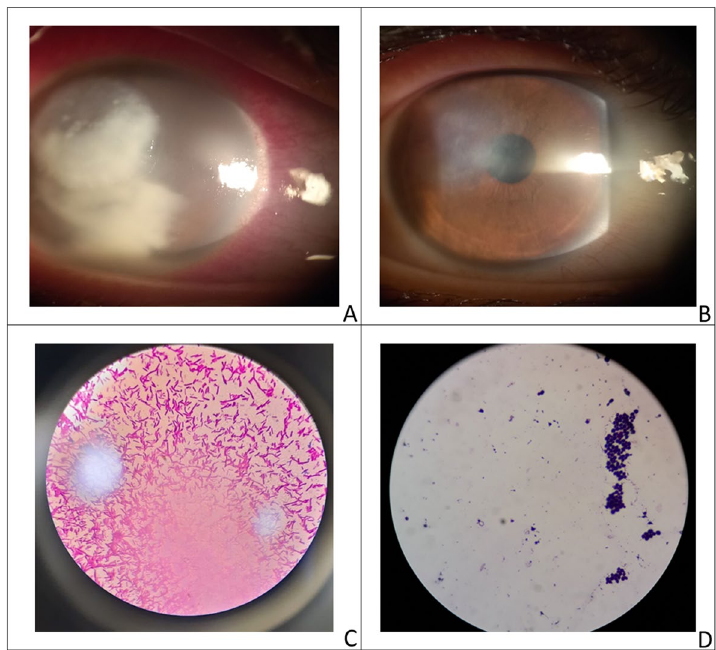
Fig. 5 A case of mixed bacterial and fungal keratitis pre ( A ), and post treatment ( B ), Gram negative bacilli; Pseudomonas (magnificationX1000) ( C ), budding yeast cells; Candida spps (magnificationX1000) ( D